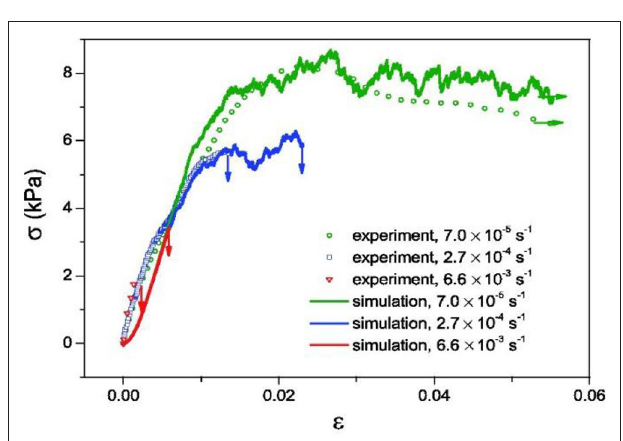
FIGURE 8 | Comparison of FBM and experimental results for displacement-controlled conditions. Reprinted from the Journal of Glaciology with permission of the International Glaciological Society